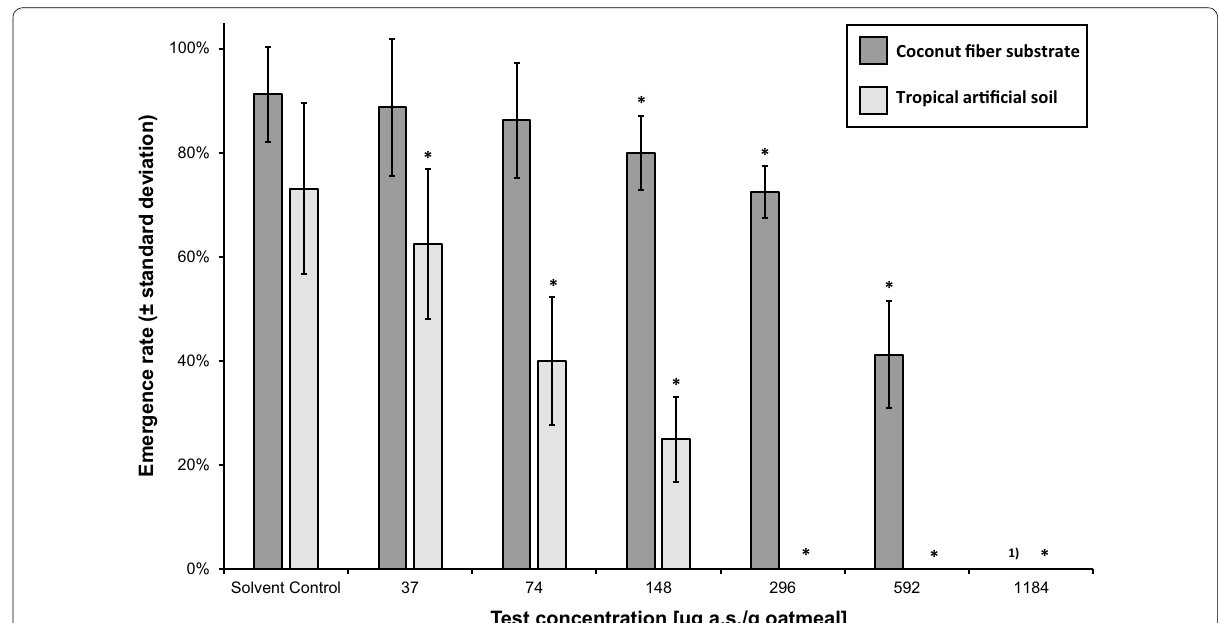
Fig. 4 Effect of neem oil (a.s. azadirachtin)-spiked oatmeal in coconut fiber substrate and tropical artificial soil at 20 °C on the emergence rate ( standard deviation) of Bradysia impatiens . *Significant difference between treatment and solvent control ( χ 2 -test with Bonferroni correction, ± one-sided smaller, p 0.05). a.s. active substance. 1) Concentration not tested ≤